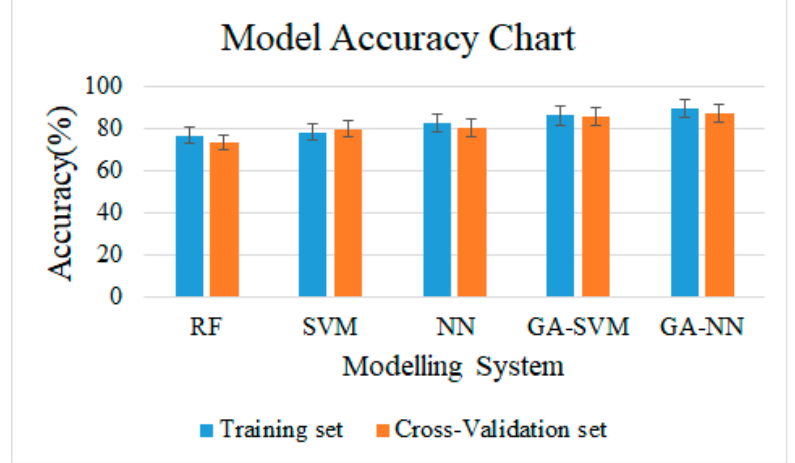
Figure 9. The accuracy chart of the different modelling systems.